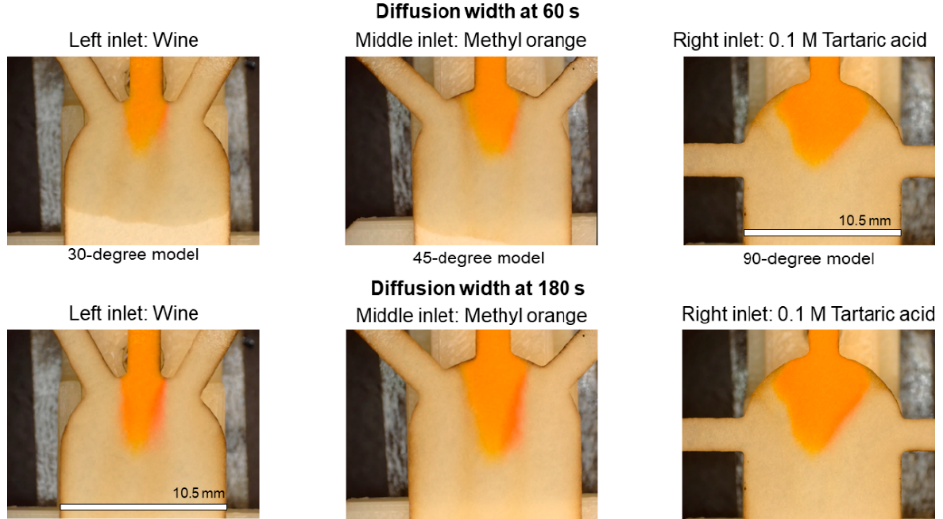
Figure 7. Experimental value of the required time to develop a 1.5 mm diffusion width at the measurement line. The reported values are the median time for each model by considering all the working reagents. The units are in seconds. Figure 8 compares the interaction between the pH indicator (middle inlet) and the reagents (0.1 M tartaric acid and wine) over the time, in the three different models (30- degree, 45-degree and 90-degree). In the measurements done at 120 s after the “Time zero”, the diffusion width increases considerably in the 30-degree and the 45-degree models. Moreover, in the 30-degree model, the shift of the pH indicator color is visible with the naked eye. Meanwhile, in the 90-degree model, the color change on the tartaric acid side is barely visually distinguishable.